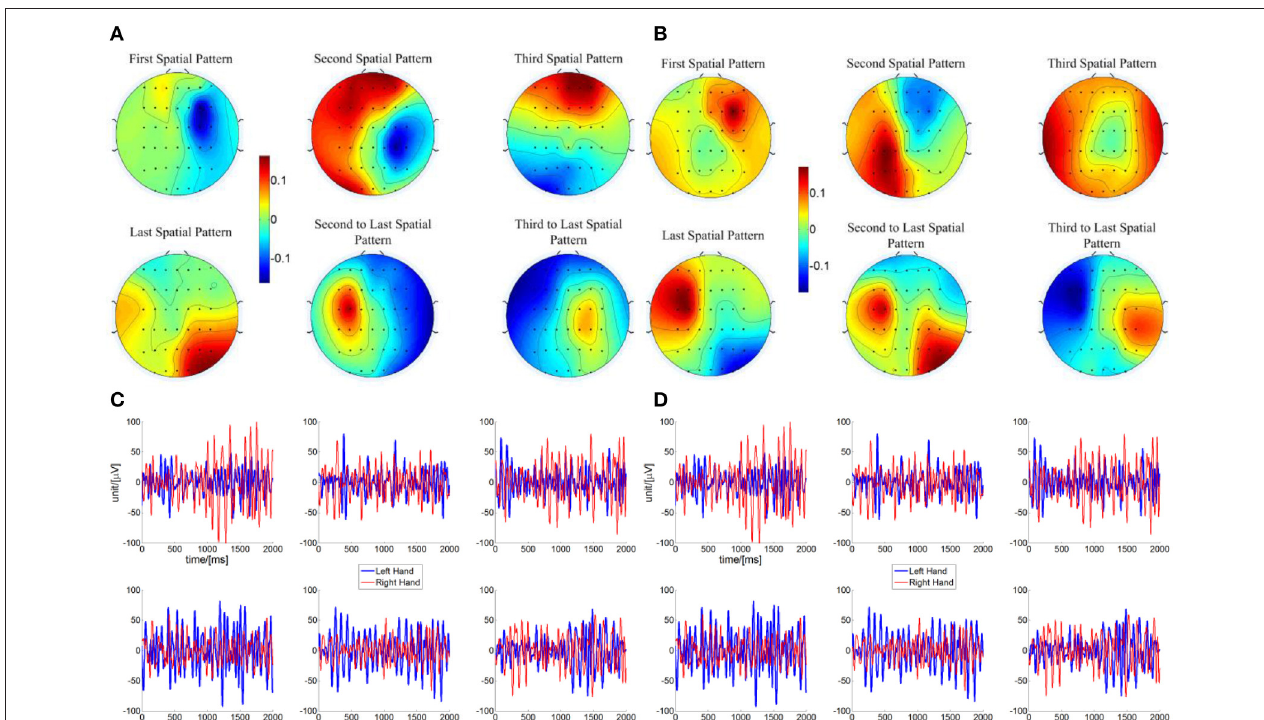
FIGURE 8 | Topography of spatial patterns calculated by CSP/L and corresponding temporal dynamics for a particular subject in the online BCI control. (A) Three pairs of spatial patterns corresponding to the three pairs of the highest ranked eigenvalues were used for a particular subject in one run of a session for online BCI control. The first and second spatial pattern in the first row together with the second and third to last spatial patterns in the second row show neurophysiological consistency with the event-related (de)synchronization (ERD/ERS) which is a typical signature of motor imagery tasks. The third spatial pattern and last spatial pattern might capture the non-sensorimotor related activities which happened to be featured by the algorithm. (B) Similar spatial patterns in another run of a session for online BCI control, indicating variability in such spatial patterns used for online classification. (C) Temporal signals after the spatial filtering from two correct hit trials-left hand imagination and right hand imagination, respectively. The spatial filters were derived from the same CSP transformation which generated the spatial patterns in (A) . (D) Similar temporal signals after spatial filtering from another two correct hit trials in the run which generate the spatial patterns in (B)